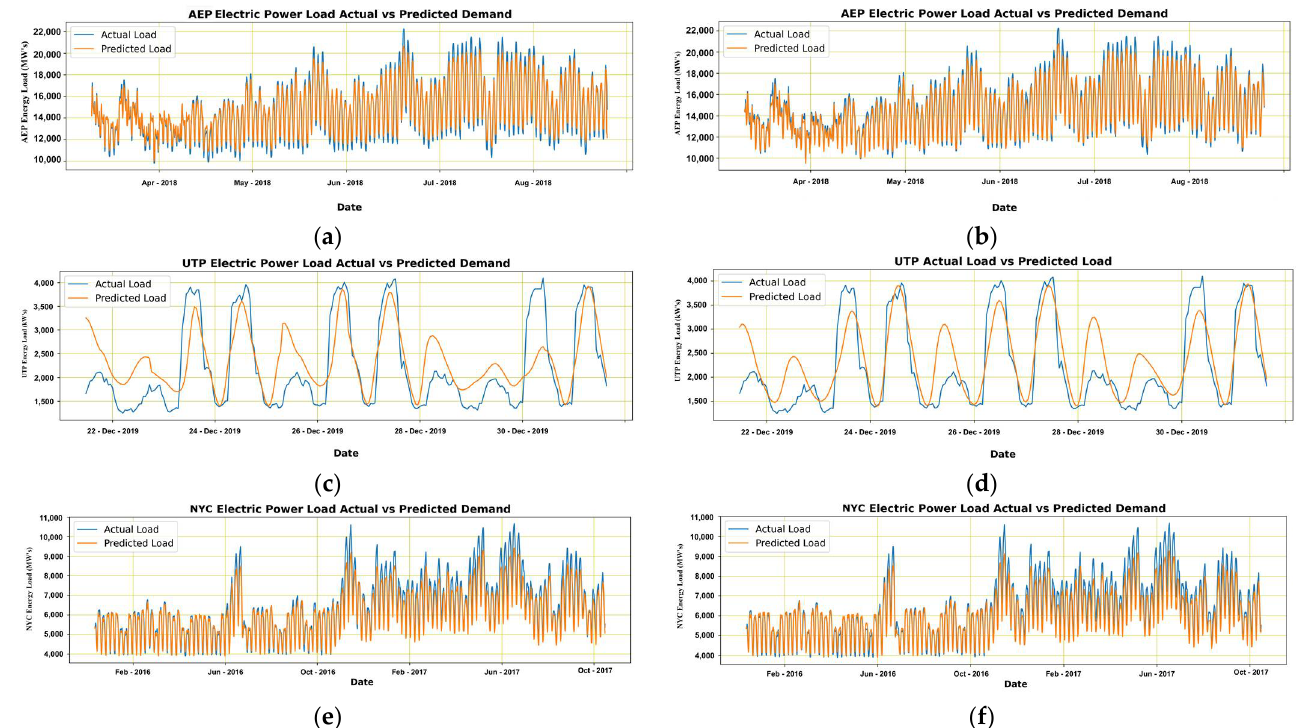
Figure 15. Actual and predicted results of A.E.P. ( a , b ), U.T.P. ( c , d ), and N.Y.C. ( e , f ) before and after parameter variation in provided dataset and forecasting model LSTM. Table 5. LSTM model performance on A.E.P., N.Y.C., and U.T.P. datasets before and after parametric